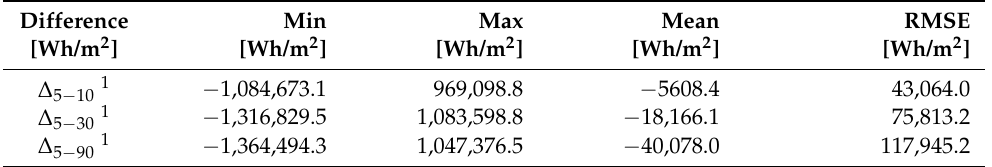
Table 3. Statistical characteristics (minimum, maximum, mean, and RMSE) of the differences in potential solar radiation calculated at different